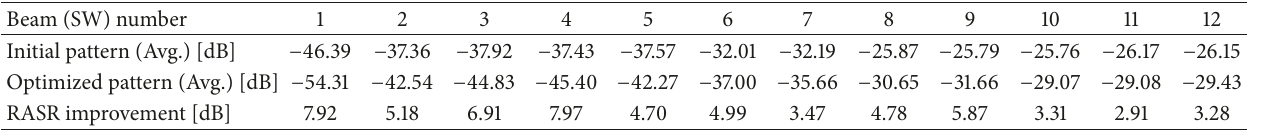
Table 4: RASR performance